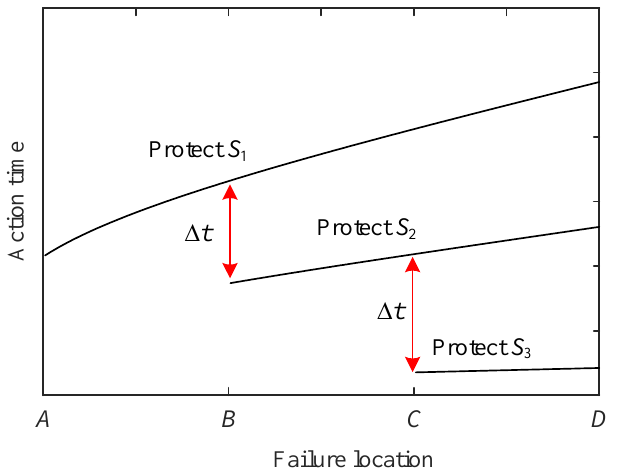
Figure 2. Dynamic characteristic curve of traditional inverse time limit protection.